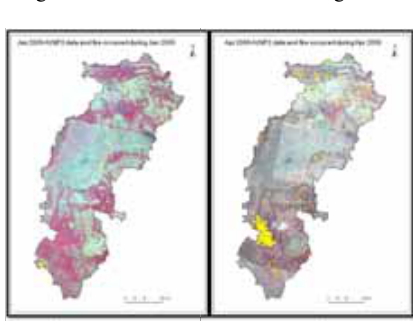
Figure 6: EVI of SAL